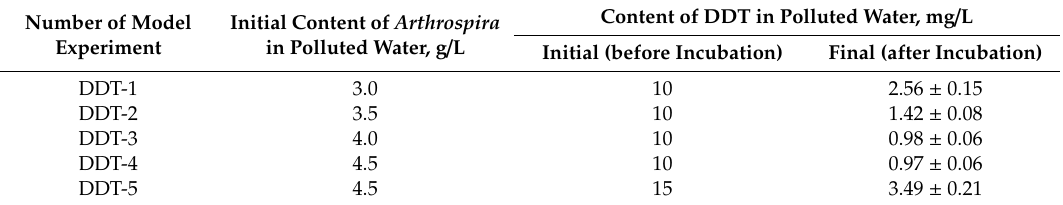
Table 1. Results of model experiments for cleaning water polluted with DDT by using Arthrospira . Mean values (n = 3) and ± SD are given.